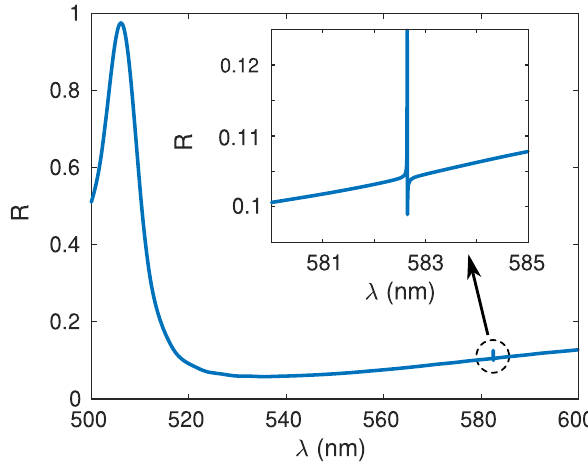
Figure 5: Reflectance spectra R ( 𝜔 ) from an infinite square array ∼ 5 . 5) nanodisks (lattice period a = 340 nm) of Bi:YIG ( 𝜖 Bi:YIG (150nm radius and 120nm height), for fixed MO activity (see text), calculated through FDTD simulations for TE